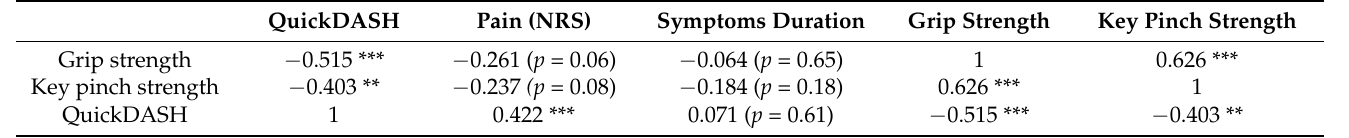
Table 4. Spearman’s correlation between hand strength and clinical factors of patients with unilateral NTOS ( n =